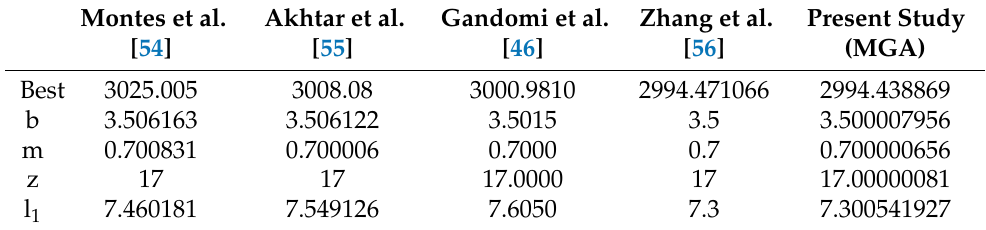
Table A1. Comparison of the best solutions for the speed reducer design